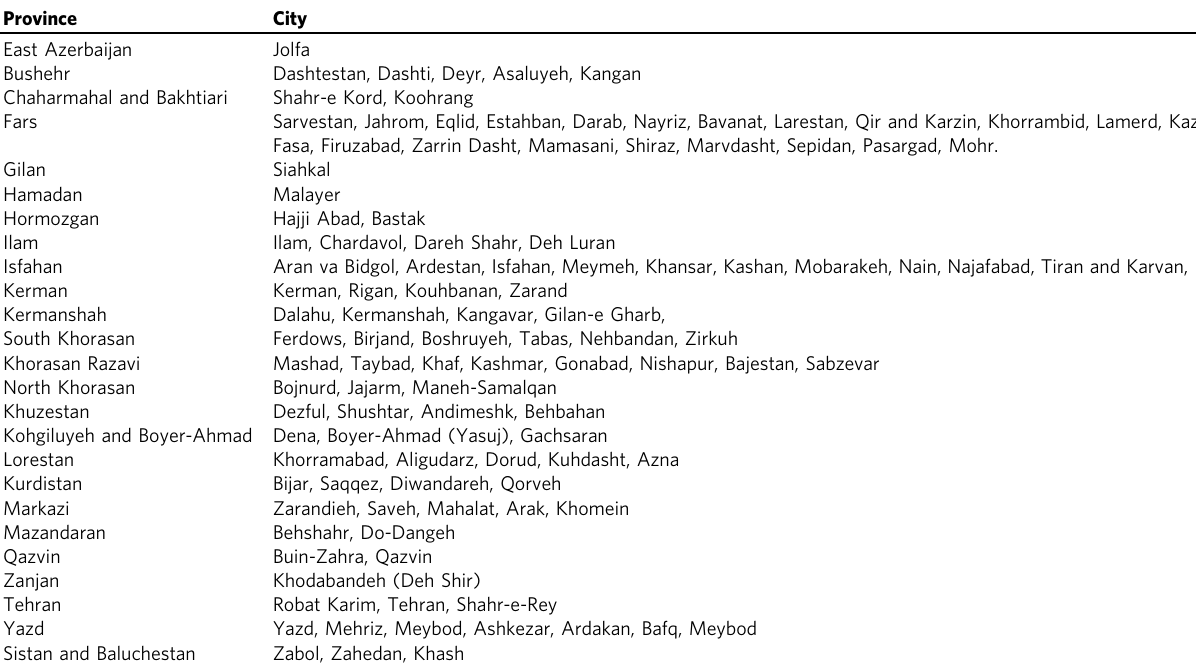
Table 3 A list showing some of the existing watermill heritage sites in